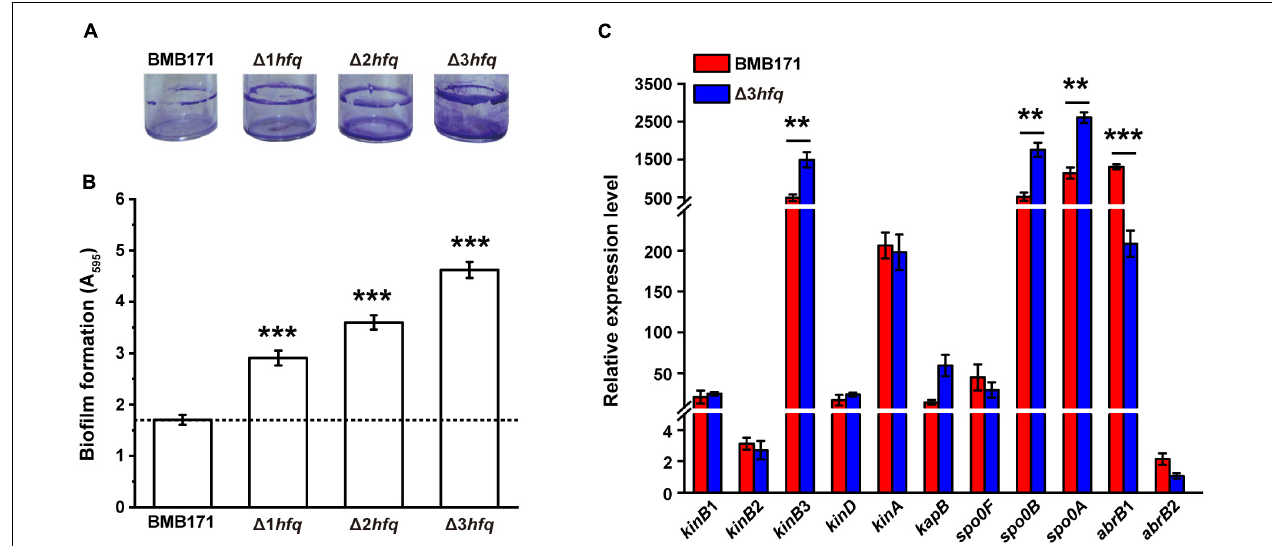
FIGURE 3 | Deletion of hfq results in increased biofilm formation. (A) Representative photographs of biofilm formation assays for the BMB171, (cid:49) 1 hfq , (cid:49) 2 hfq , and (cid:49) 3 hfq strains in glass bottles. (B) Quantification of biofilm formation for BMB171, (cid:49) 1 hfq , (cid:49) 2 hfq , and (cid:49) 3 hfq by crystal violet stain measured by UV spectrophotometer at 595 nm. (C) RT-qPCR measurements of 11 genes associated with biofilm formation in BMB171 and (cid:49) 3 hfq . The values are the mean ± SD for triplicate assays. Significances of differences by Student’s t -test are indicated. *** p < 0.001; ** p < 0.01; * p <